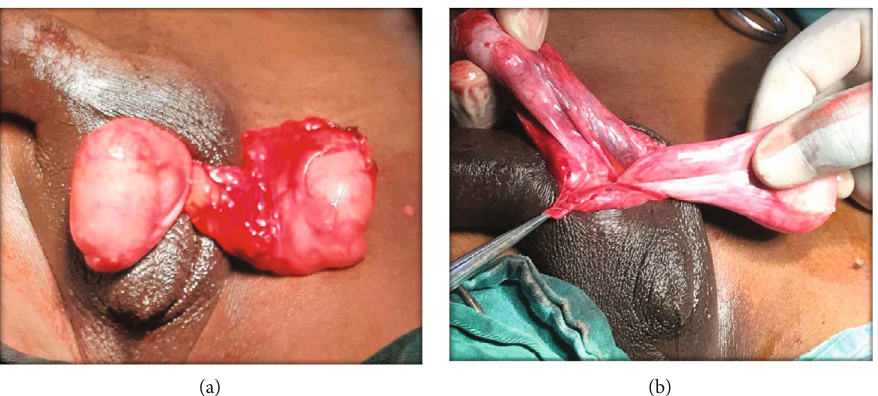
Figure 5: (a) Left and right testes shown through a median raphe scrototomy looking macroscopically normal. (b) No fusion of vessels nor vasa, nor epididymotesticular separation.